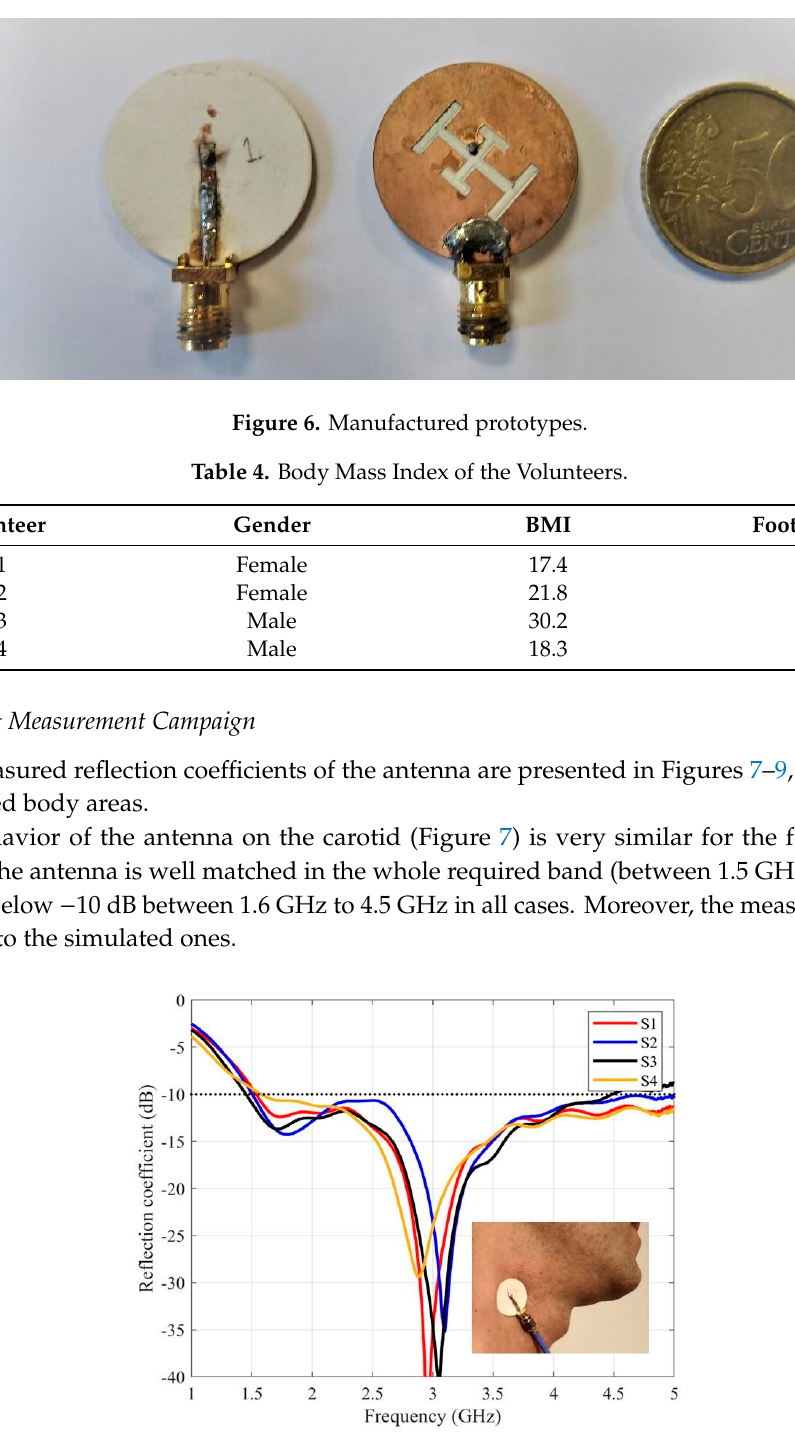
Figure 7. The measured reflection coefficients of the purposed antenna placed on the carotid.